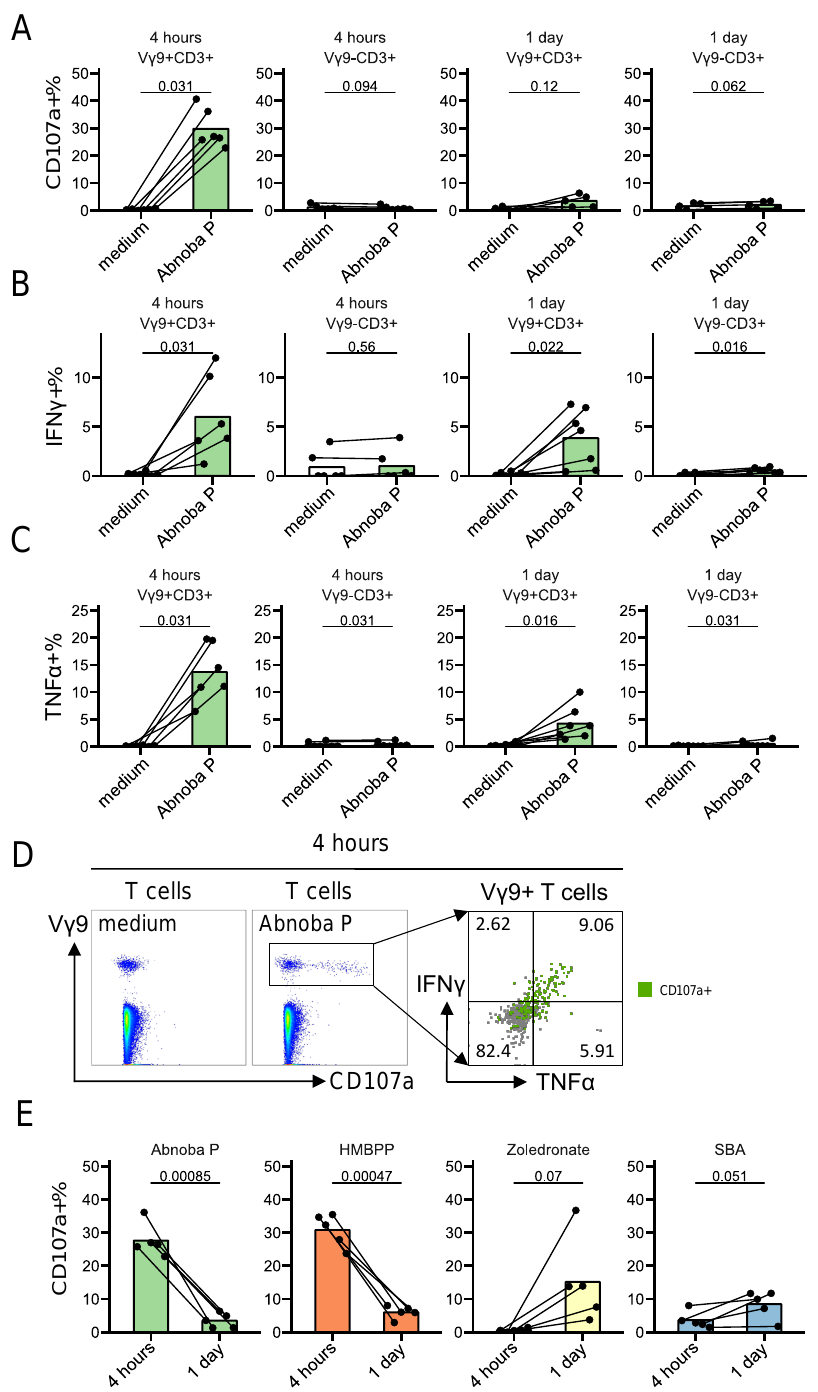
Figure 2. AbnobaViscum rapidly stimulate the release of cytotoxic granules and the production of IFN γ and TNF α in V γ 9V δ 2 T cells. ( A – C ) CD107a (A), IFN- γ (B) and TNF- α (C) expression on V γ 9 + T cells and V γ 9 − T cells after AbnobaViscum Pini (Abnoba P) stimulation. Lines connect the same subjects ( n = 6), bars indicate mean value. Values on the graphs indicate p values (obtained with the Wilcoxon signed-rank test). ( D ) Representative flow cytometry plots (4 h stimulation): the first two plots are gated on T cells (medium control on the left, Abnoba P on the right), the third plot is gated on V γ 9 + T cells (Abnoba P), illustrating CD107a, IFN γ and TNF α co-expression ( E ) Kinetics of CD107a expression on V γ 9 + T cells by Abnoba P, HMBPP, zoledronate and sec-butylamine (SBA). Lines connect the same subjects ( n = 5), bars indicate mean values. Values on the graphs indicate p values (obtained with the paired T